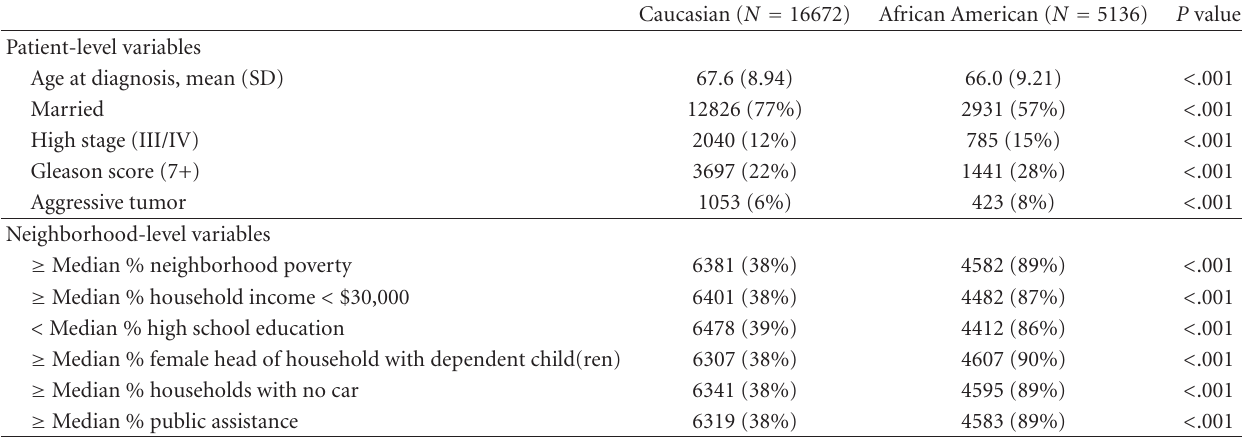
Table 1: Demographics of southeastern Pennsylvania cancer registry prostate cancer patients (1995–2007).